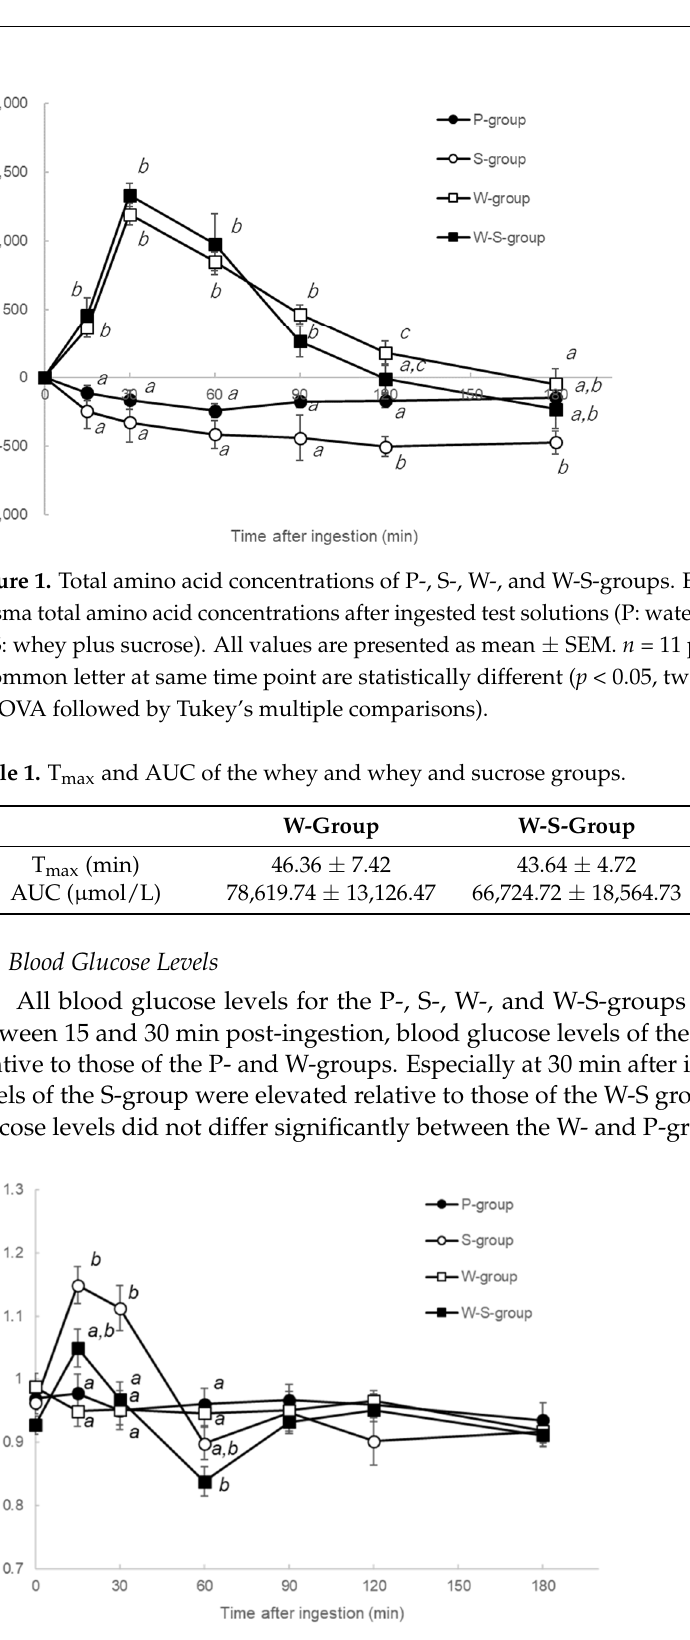
Figure 2. Blood glucose levels of P-, S-, W-, and W-S-groups. Each group was measured plasma glucose levels after ingested test solutions (P: water, S: sucrose, W: whey, and W-S: whey plus sucrose). All values are presented as mean ± SEM. n = 11 per group. Means without a common letter at same time point are statistically different ( p < 0.05, two-way repeated measures ANOVA followed by Tukey’s multiple